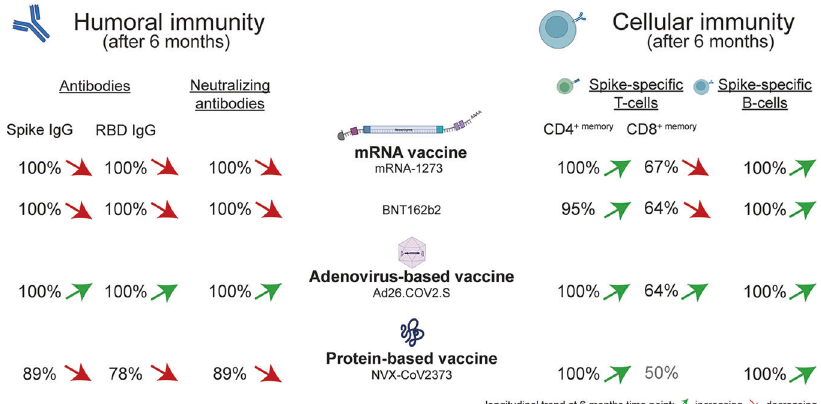
Fig. 1 Humoral and cellular immune responses after mRNA- (mRNA-1273, BNT162b2), adenovirus- (Ad26.COV2.S), and recombinant protein- based (NVX-CoV2373) vaccination are illustrated. Responder rates and the longitudinal trend at a 6-month time point are depicted as observed by Zhang et al. and are consistent with the relatively high degree of protection maintained against infection and severe disease after vaccination. Of note, response rates in the humoral and cellular compartment may have peaked before the 6-month time point. mRNA vaccines were consistently observed as the most immunogenic, with immune response levels higher than or equal to the other vaccines. In contrast, Ad26.COV2.S vaccination elicited a generally lower but relatively stable immune response. While NVX-CoV2373-induced neutralizing antibody titers and memory CD4 + T cell proportions were comparable to the mRNA vaccines, the induction of spike-speci fi c CD8 + T cells was low in NVX-CoV2373 and needs further evaluation. This fi gure was created using BioRender. RBD receptor-binding